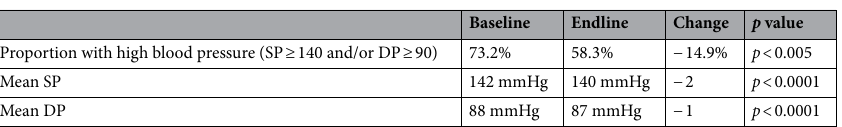
Baseline Endline Change p value